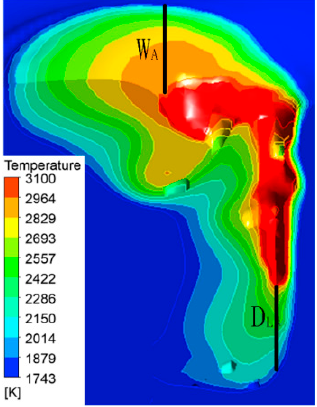
Figure 9. Simulation of melt pool at 35 ms.